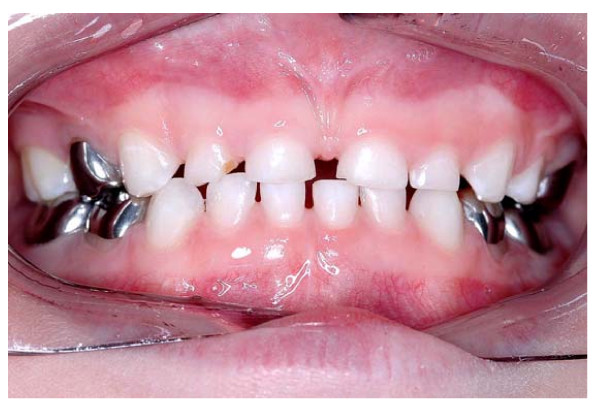
Clinical photograph of a patient with six PMCs fitted using the Hall Technique at separate appointments. The occlusion has adjusted to give even contact between the arches.